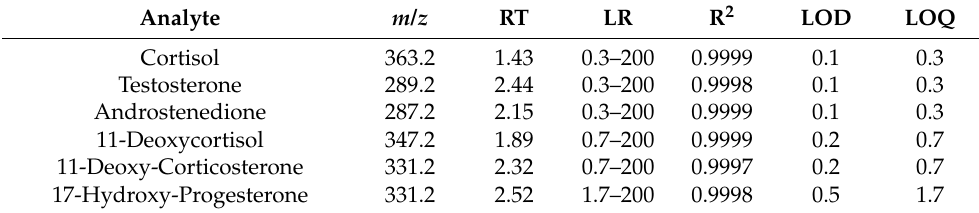
Table 2. Optimized UPLC–MS parameters for each steroid